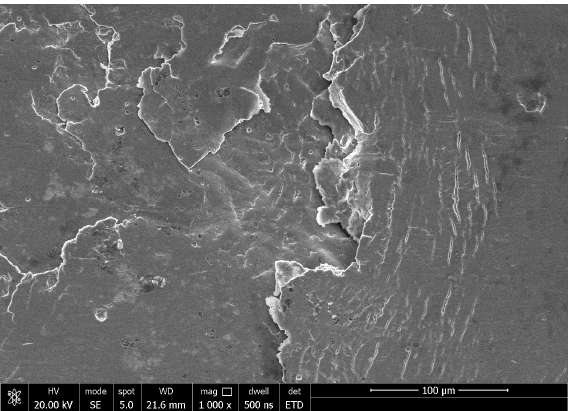
Figure 4. Contact fatigue spalling morphology of the inner ring raceway.